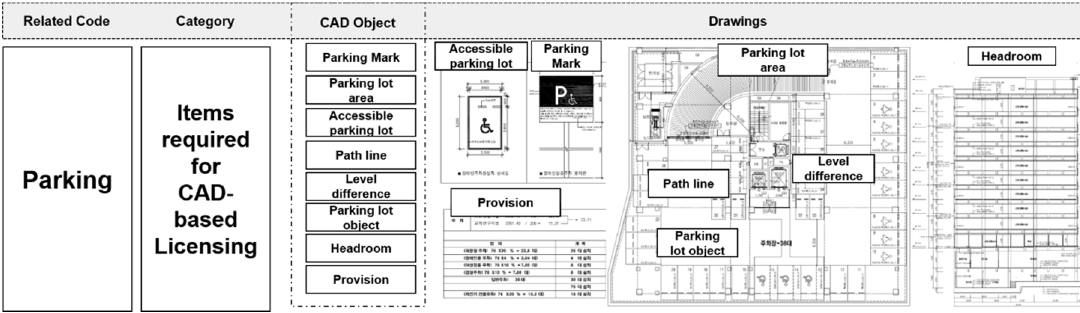
Figure 8. Drawing requirements and example drawings in the computer-aided design (CAD).